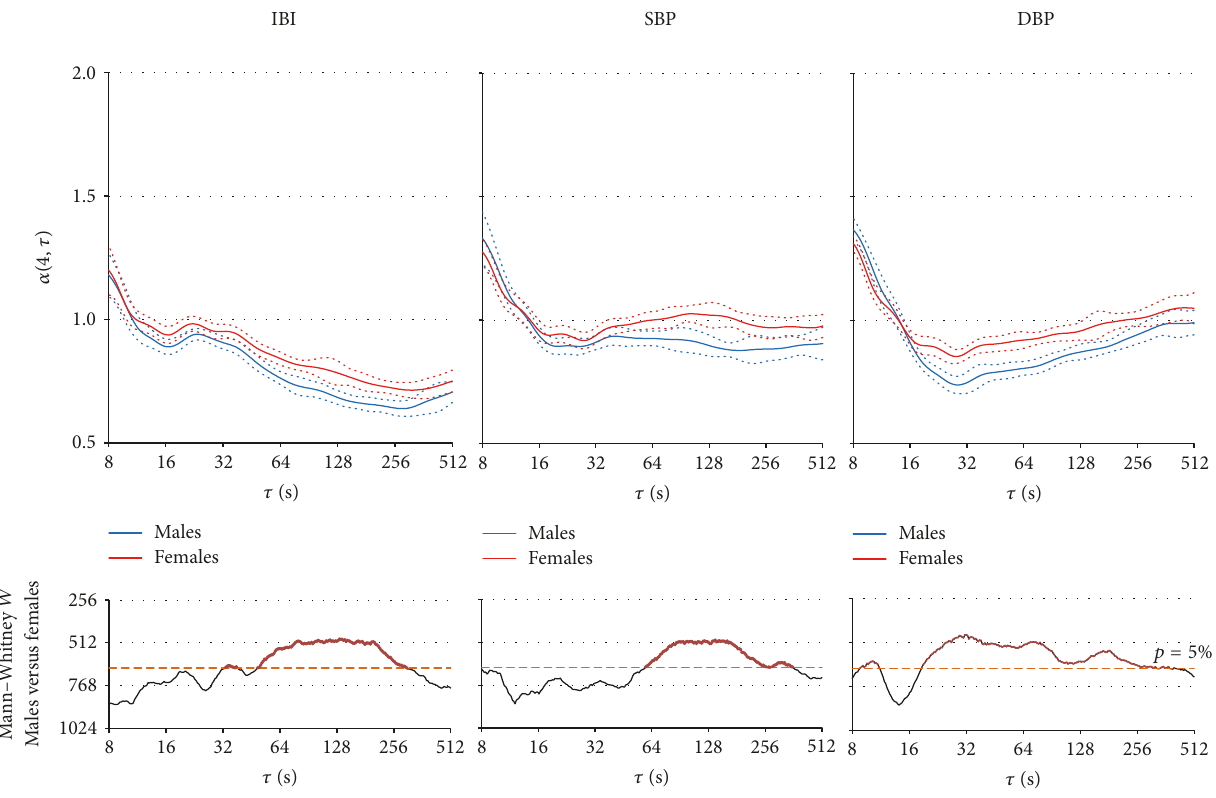
Figure 7: Multifractal-multiscale coefficients, 𝛼(𝑞, 𝜏) : comparison by sex . Mean ± standard error of the mean (upper panels) and 𝑊 statistics of Mann–Whitney tests (lower panels) for comparing males ( 𝑁 = 42 ) and females ( 𝑁 = 42 ), as function of 𝜏 . Dashed horizontal lines represent the 5% significance threshold; 𝑊 values above the threshold (red dots) indicate differences significant at 𝑝 < 5 %. From top to bottom: 𝑞 = −4 ; 𝑞 = 0 ; 𝑞 = +4